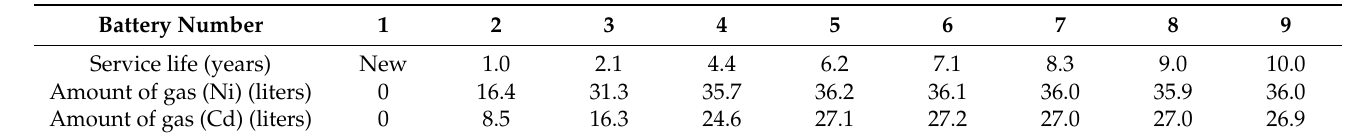
Table 2. Dependence of the amount of accumulated hydrogen in one electrode of the KPL-14 battery (with pocket electrodes) on the battery service life 1